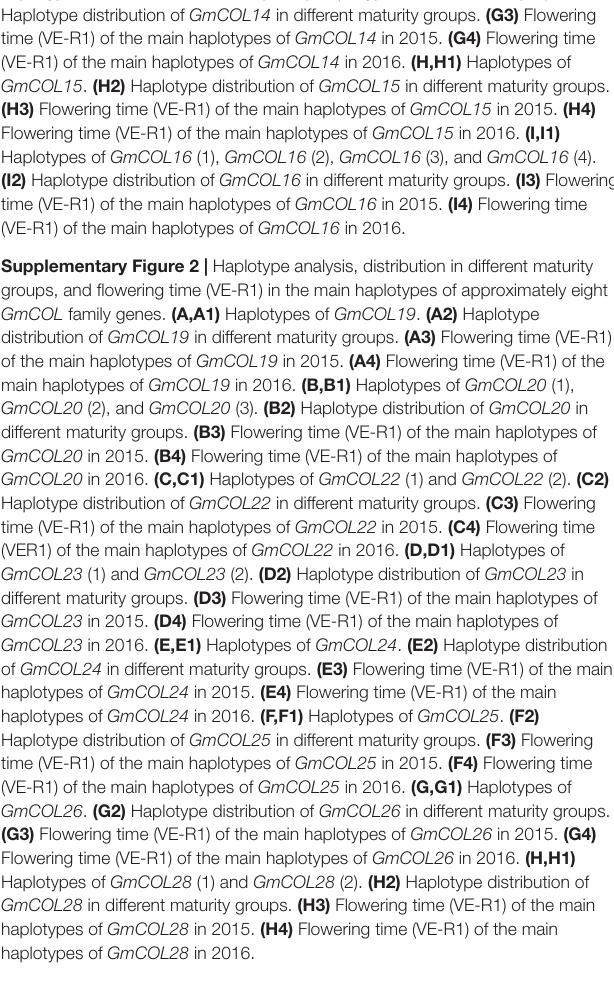
Supplementary Figure 1 | Haplotype analysis, distribution in different maturity groups, and flowering time (VE-R1) in the main haplotypes of approximately nine GmCOL family genes. (A,A1) Haplotypes of GmCOL4 . (A2) Haplotype distribution of GmCOL4 in different maturity groups. (A3) Flowering time (VE-R1) of the main haplotypes of GmCOL4 in 2015. (A4) Flowering time (VE-R1) of the main haplotypes of GmCOL4 in 2016. (B,B1) Haplotypes of GmCOL6 . (B2) Haplotype distribution of GmCOL6 in different maturity groups. (B3) Flowering time (VE-R1)